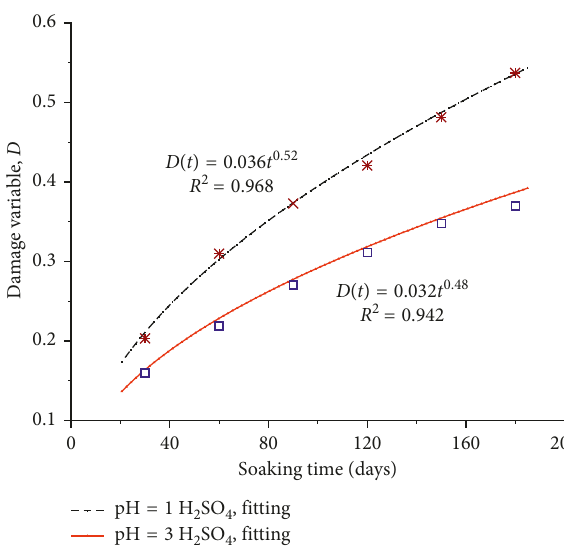
Figure 15: Relationship between the damage variables of the sandstone samples and immersion time under different pH sulfuric acid